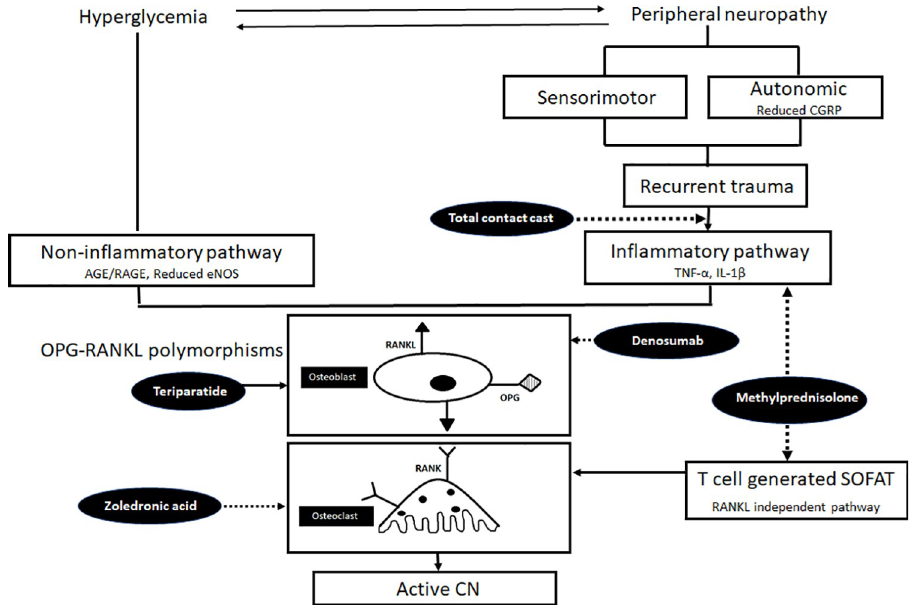
Fig 4. Integrated pathophysiology and interactions between various factors in persons with diabetes implicated for the causation of active Charcot neuroarthropathy and efficacy of various evaluated therapeutic agents. AGE- Advanced glycation end products; RAGE- Receptor for advanced glycation end products; eNOS- Endothelial nitric oxide synthase; SOFAT- secreted osteoclastogenic factor of activated T cells; RANKL- Receptor activator of nuclear factor- к β , OPG- Osteoprotegerin; CGRP- Calcitonin gene related peptide; Charcot’s neuroarthropathy (CN).